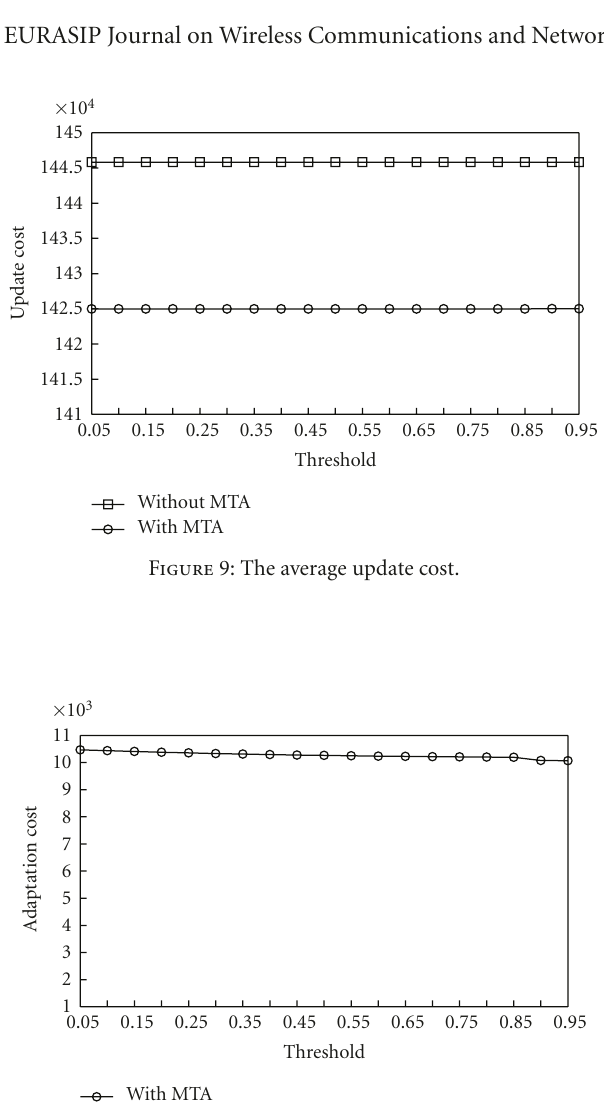
Figure 10: The average adaptation cost using MTA procedure.